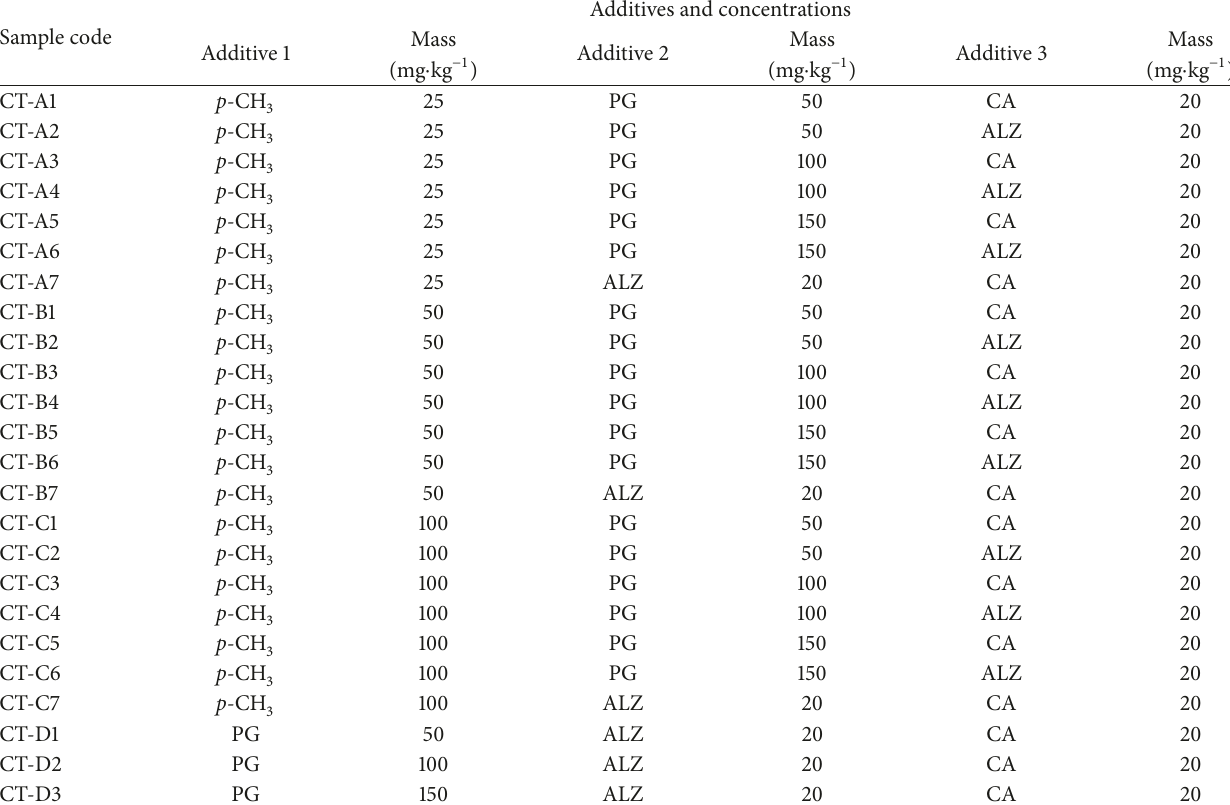
Table 3: Samples doped in ternary combinations at different concentrations and the presence of